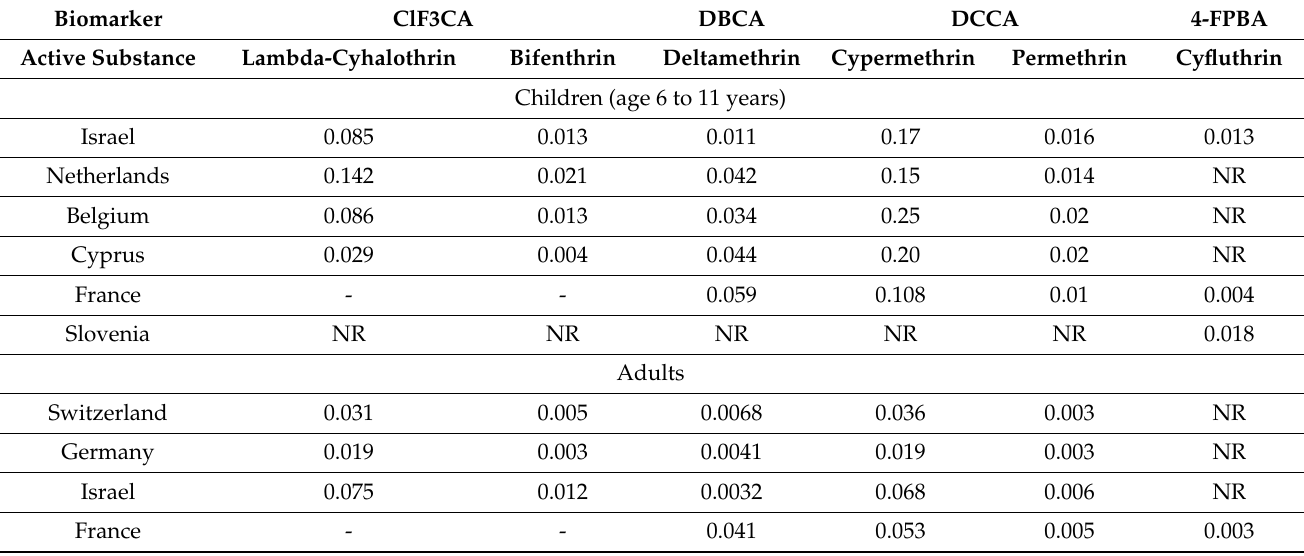
Table 5. Risk characterization ratios (RCR) for substance specific biomarkers. NR indicates that the 95th percentile could not be estimated due to low detection